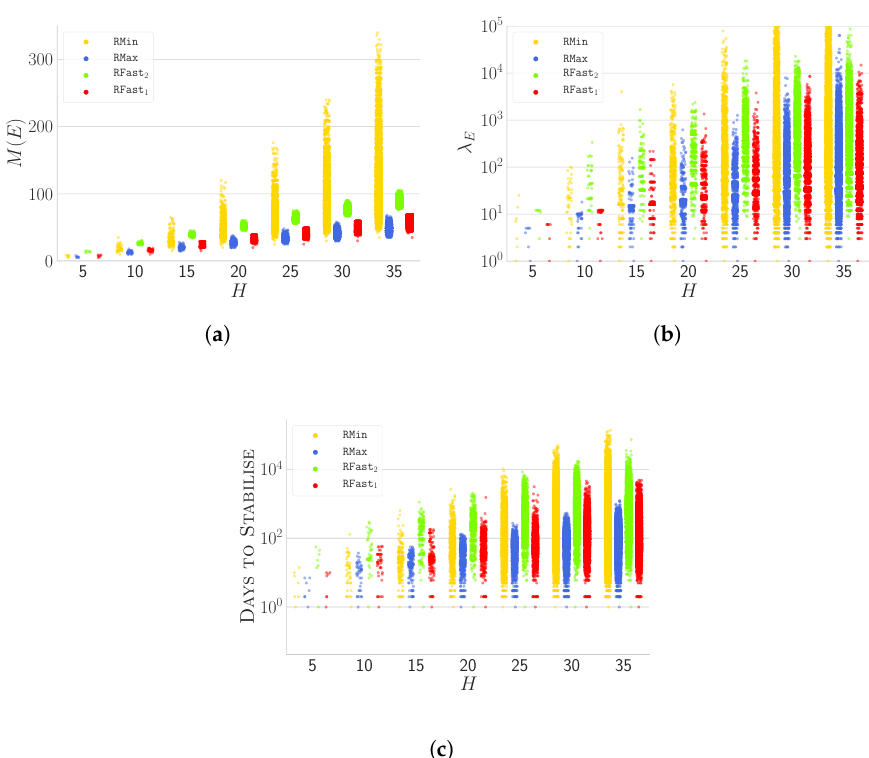
Figure 6. Distribution of values of: M ( E ) ( a ); λ E ( b ); and number of days before stabilisation ( c ) as a function of H , for all considered strategies and